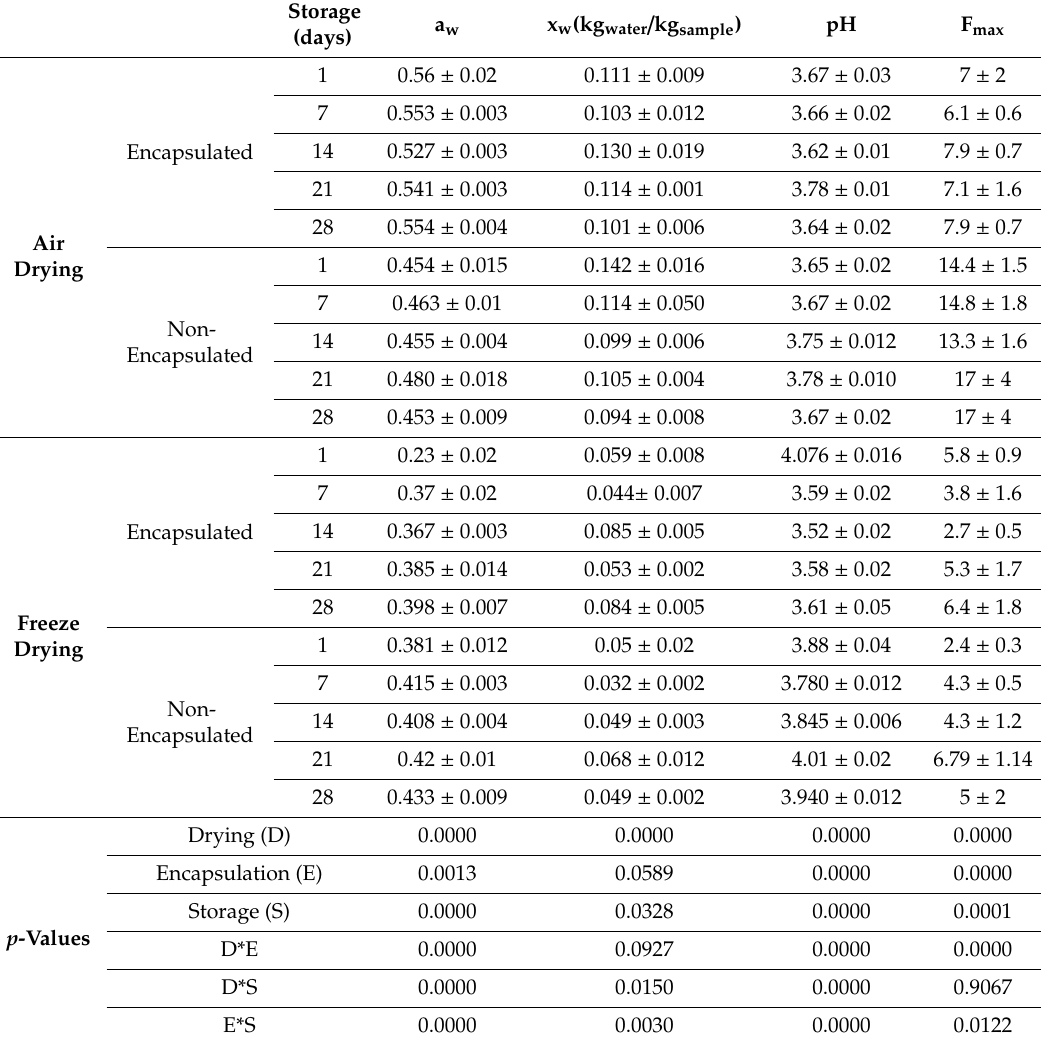
Table 1. Physicochemical characteristics (pH, water activity (a w ), and moisture content (x w )) and F max of dried apples with encapsulated and non-encapsulated microorganisms during 28 days of storage. Results expressed as mean ± standard deviation of at least three